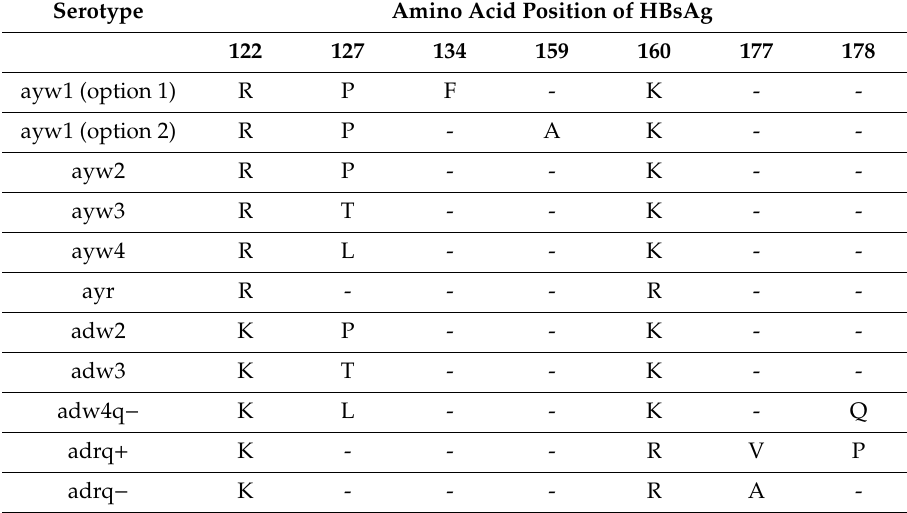
Table 1. Amino acid combinations within hepatitis B virus surface antigen (HBsAg) used to